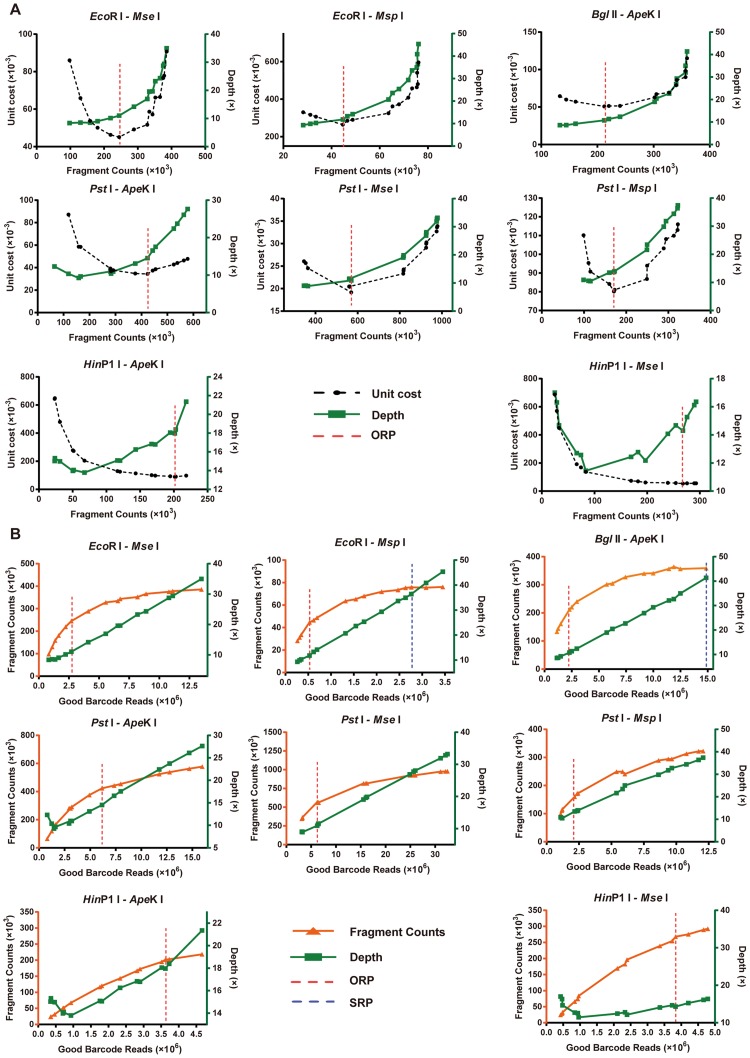
Relationship of ORP/SRP with good barcode reads for eight double-enzyme combinations.A) The function of unit sequencing cost of fragments was calculated by plotting sequencing depth versus fragment counts. The ORP was defined as the minimum value of the unit sequencing cost (the minimum value of the black-dashed line). B) The sequencing reads of three individuals were sampled at five thresholds (10%, 20%, 50%, 80%, and 100%, respectively). The sequencing depth (green) was equal to the good barcode read numbers divided by the fragment counts. The SRP was the corresponding good barcode reads when the slope of the fragment counts (orange curve) reduced to zero.